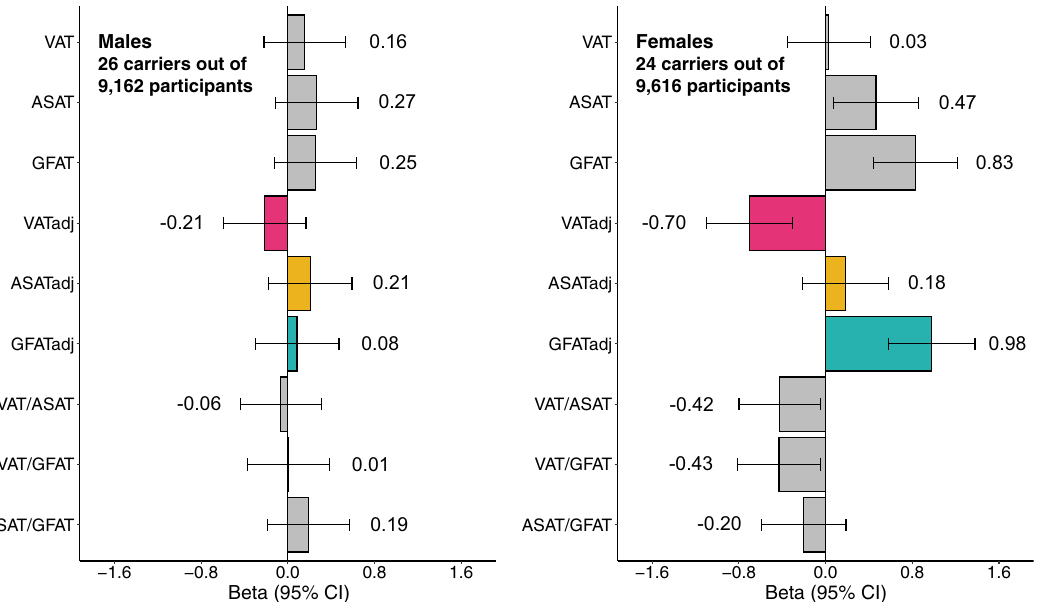
ASAT/GFATVAT/GFATVAT/ASATGFATadjASATadjVATadjGFATASATVAT Fig. 5 Rare variants in PDE3B selectively associate with fat distribution in female participants. A mask combining predicted loss-of-function variants and missense variants predicted to be deleterious by 5 out of 5 in silico prediction algorithms in PDE3B associated with GFATadj in females with exome-wide signi fi cance (Supplementary Data 15). Effect sizes with 95% con fi dence intervals are plotted for carrier status. Linear regressions were adjusted for age, age squared, imaging center, genotyping array, and the fi rst ten principal components of genetic ancestry (Supplementary Data 16). Note that the carrier counts are with respect to individuals who had “ adj ” traits available. For the other six traits, the carrier counts are 26 carriers/9616 participants for males and 25 carriers/9879 participants for